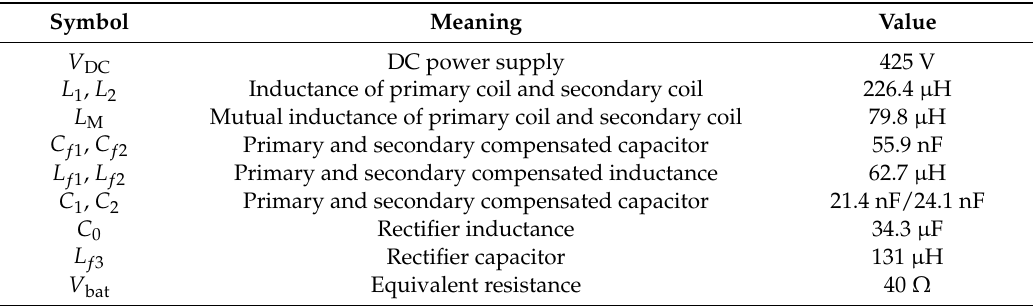
Table 2. Circuit parameters of wireless charging system (WCS).